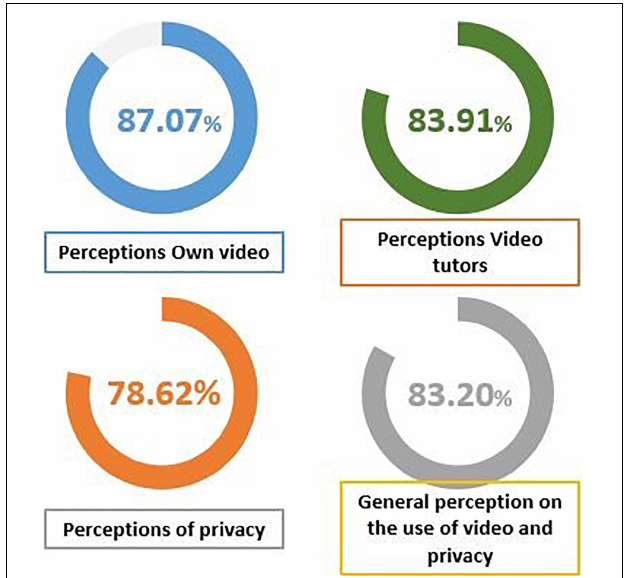
FIGURE 6 | Overall